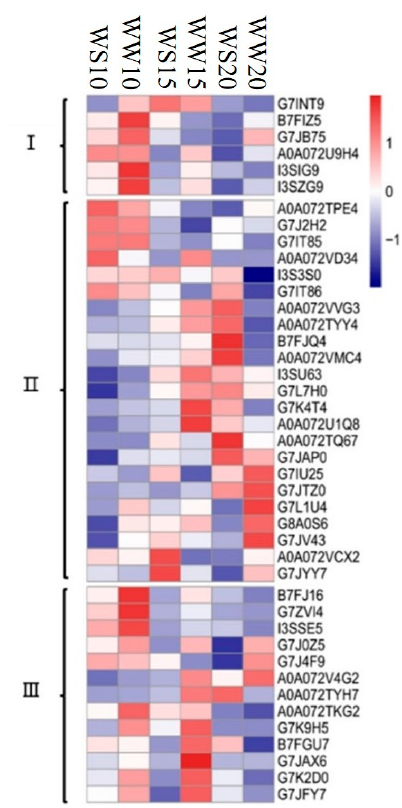
Figure 5. Cluster analysis of proteins involved in the significant pathway related to photosynthesis in pod walls at different durations after pollination under WW and WS. I, photosynthesis—antenna proteins; II, carbon fixation in photosynthetic organisms; III, photosynthesis.